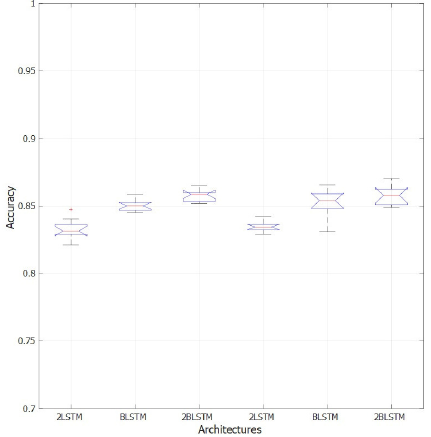
Figure 7. Effect of shuffling sequences at every epoch over the performance of the two LSTM layers network (2LSTM), the one bidirectional LSTM layer (BLSTM) and two bidirectional LSTM layers network (2BLSTM). The three leftmost boxplots represent the performance of the tested networks without data shuffling, while the three rightmost ones represent the performance of the same networks with data shuffling. Observations beyond the whisker length are marked as outliers and they are represented with “+” symbol.